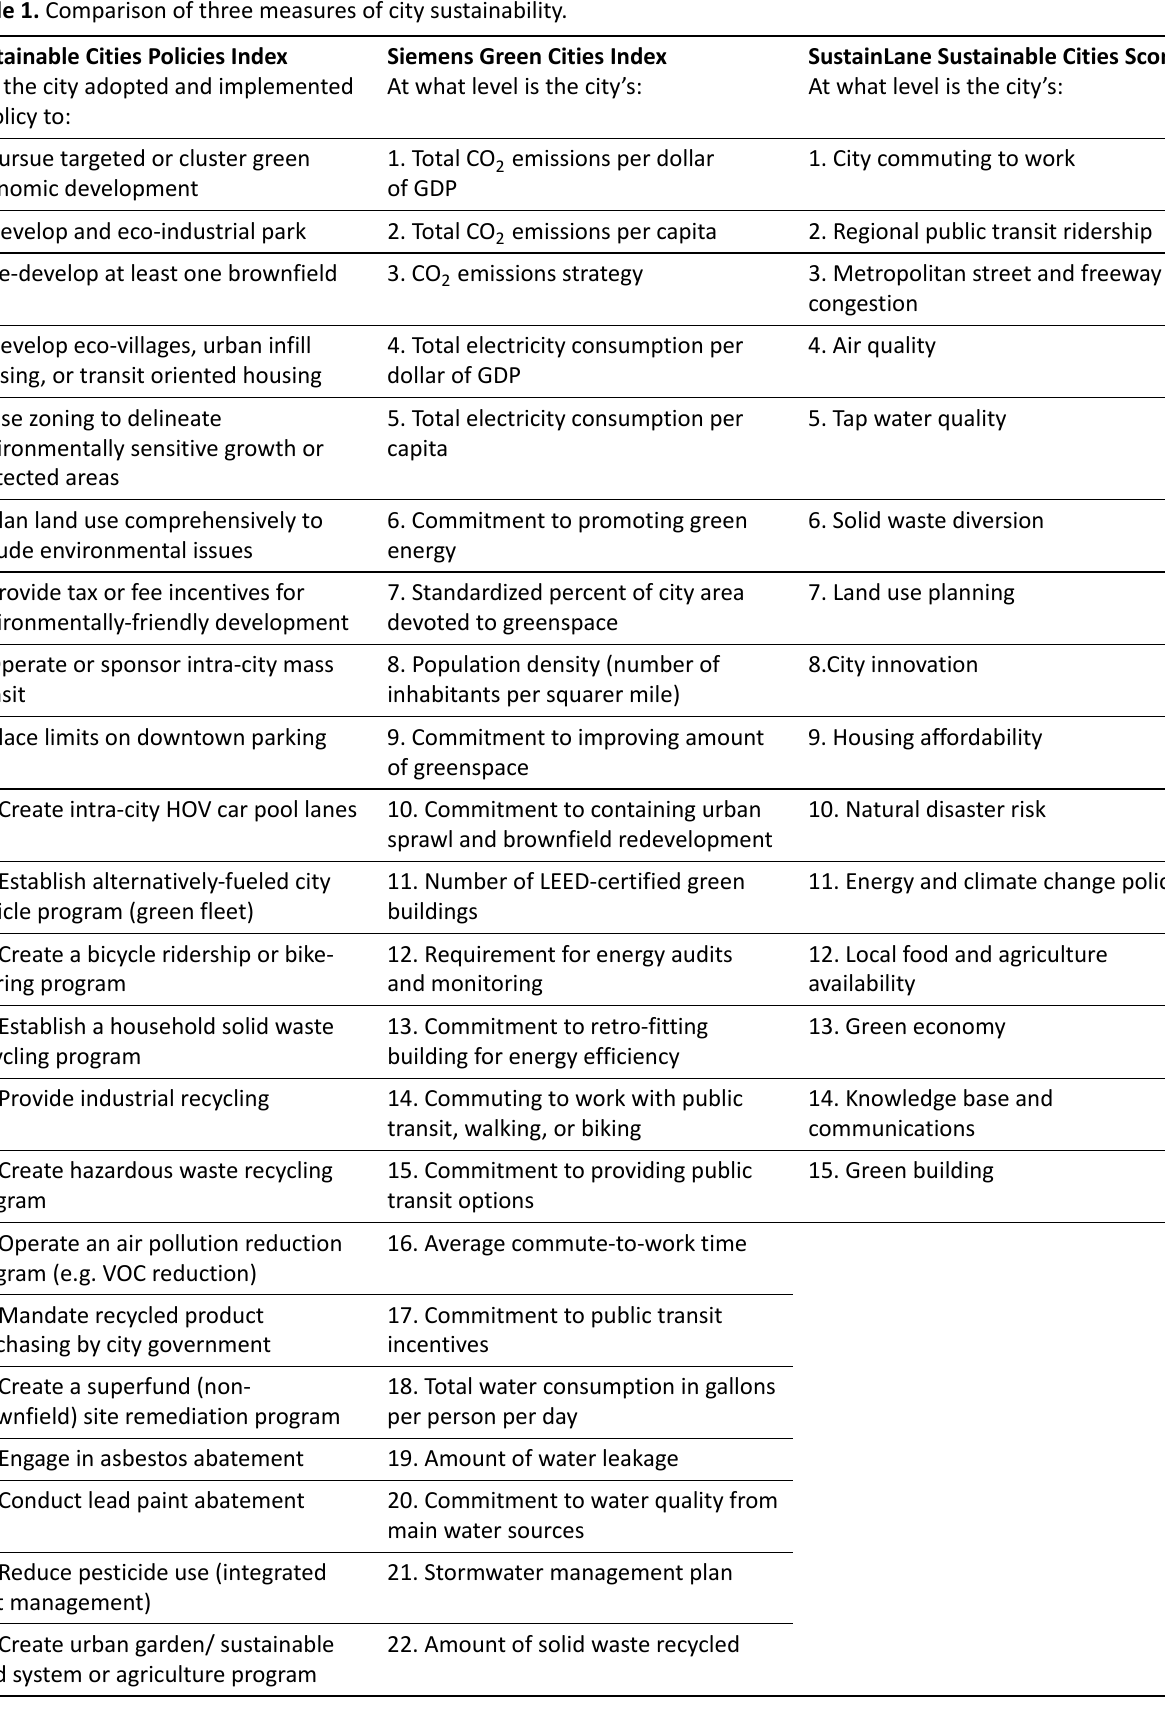
Table 1. Comparison of three measures of city sustainability. Sustainable Cities Policies